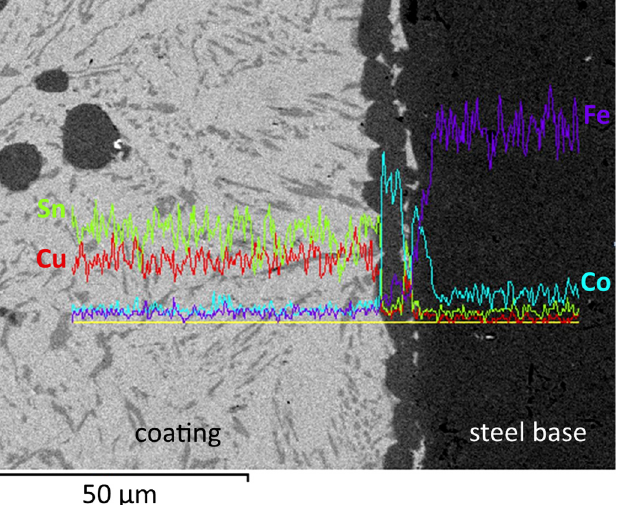
Figure 6. Microstructure and EDX microanalysis of the interface layer between the coating binder and the steel base.